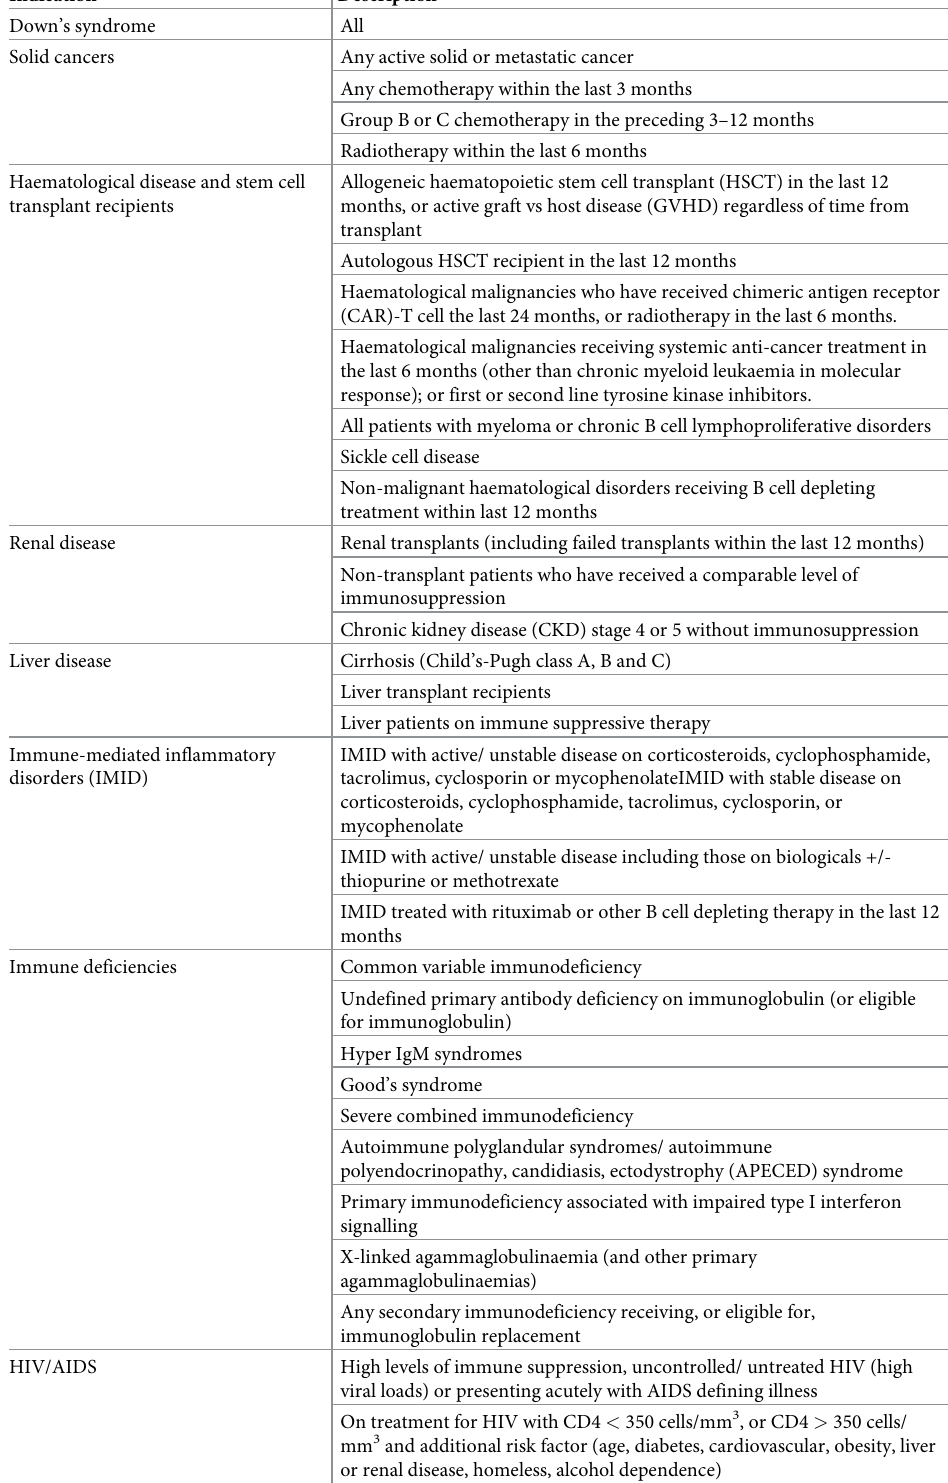
Table 1. Criteria for being “high risk” of adverse outcomes from Covid-19